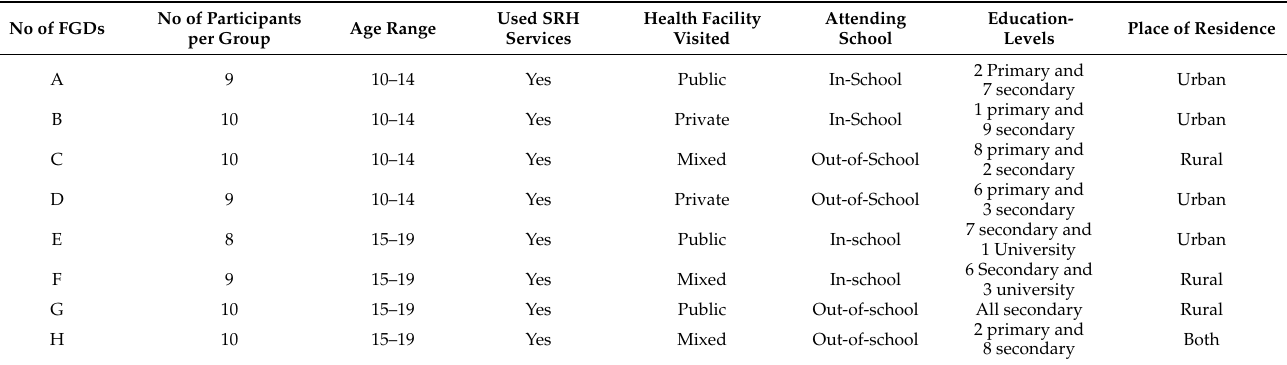
Table 2. Summary of focus group discussion participants’ characteristics-Nigeria.